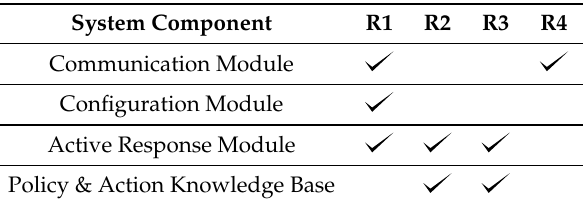
Figure 2. System components of the Reactive Protection System. Table 2. Mapping between Requirements and Reactive Protection System